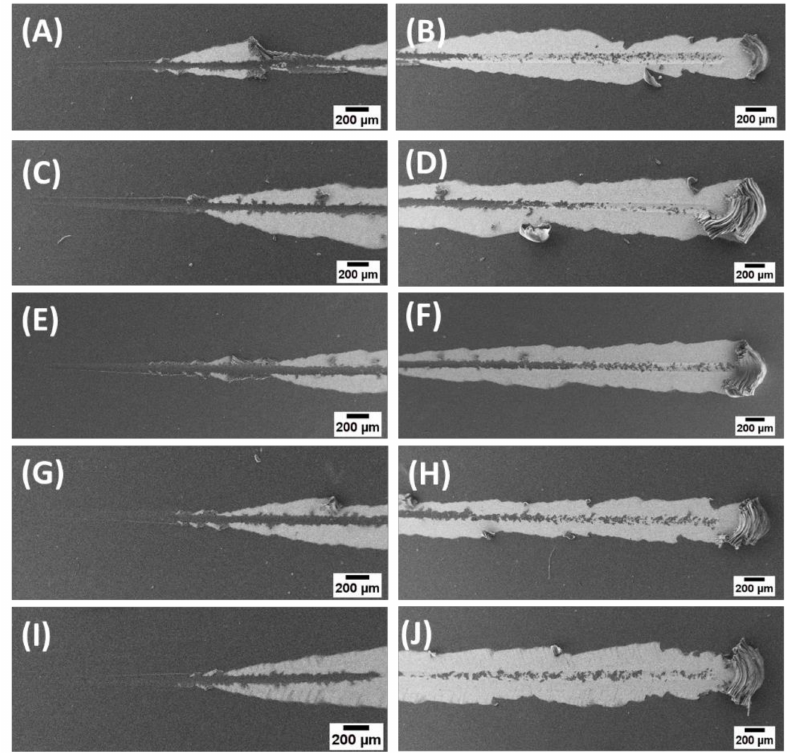
Figure 6. SEM micrographs of scratches at low (1 N) and high (10 N) loads on ( A,B ) CS, and on Ga (III)-CS coatings at ( C,D ) 1:32, ( E,F ) 1:16, ( G,H ) 1:8, and ( I,J ) 1:4